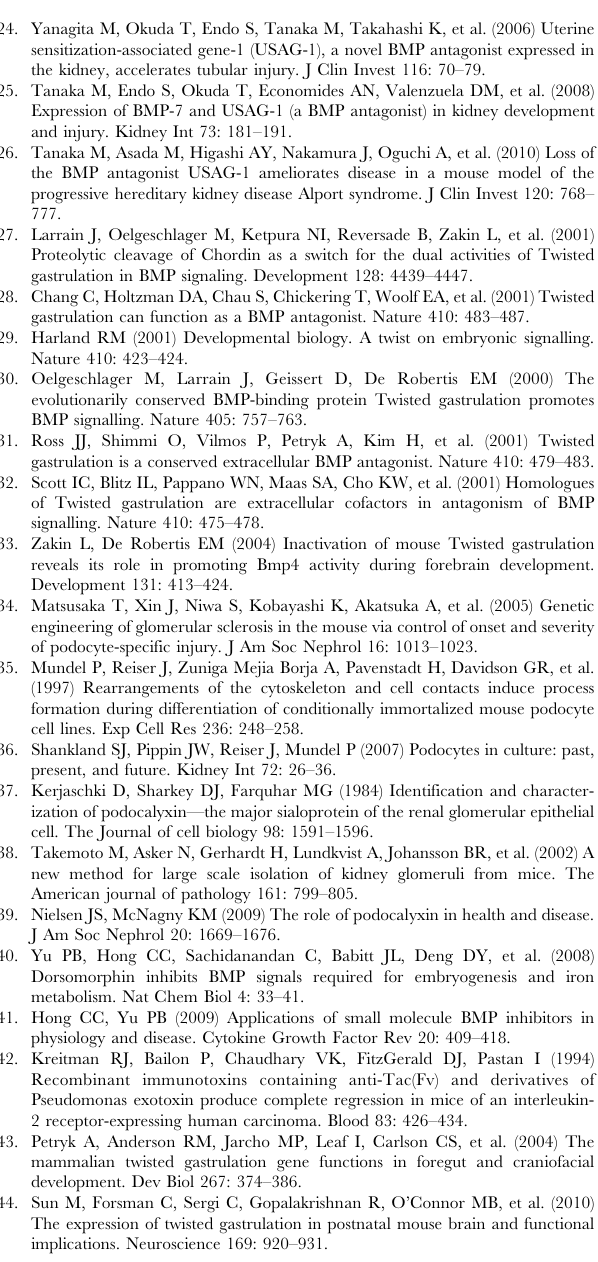
respectively, and the band near the middle of each box indicates the median. The ends of the whiskers represent the minimum and maximum of all data. NS, no significant difference. (TIF) Figure S3 Real-time PCR of hCD25 in the samples of Figure 3E. Data were normalyzed to those of GAPDH. Data are presented as means 6 SD. NS, no significant difference. (TIF) Figure S4 (A) Representative immunostaining of podocalyxin in Twsg1 wild-type and null mice. (B) Representative immunostain- ing of podocalyxin in Twsg1 + / + :NEP mice and Twsg1 2 / 2 :NEP mice with or without LMB2 administration. Scale bars: 100 m m.